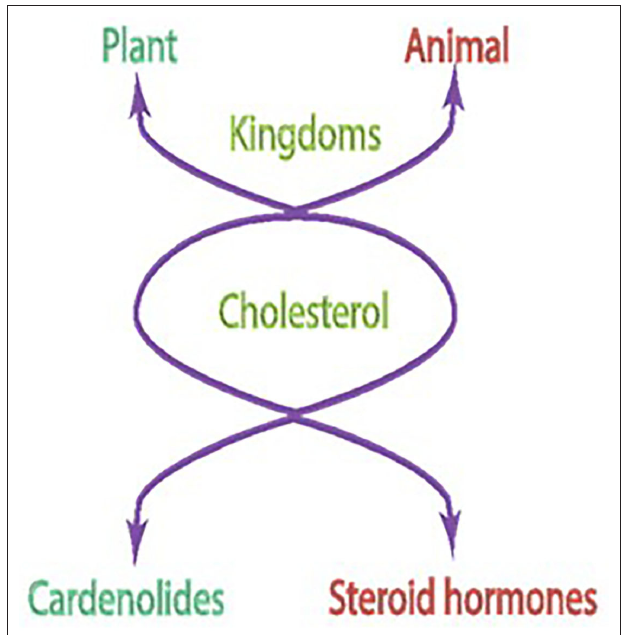
FIGURE 1 | Cholesterol is a common precursor molecule for steroids in animal and plant